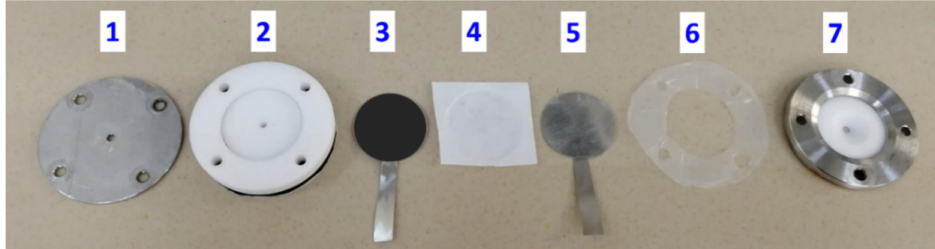
Figure 7. A two-electrode cell: 1—stainless steel plate, 2—polytetrafluoroethylene cell, 3, 5—current collectors (Ni foil), 4—separator (hydrophilic polypropylene membrane), 6—polytetrafluoroethylene